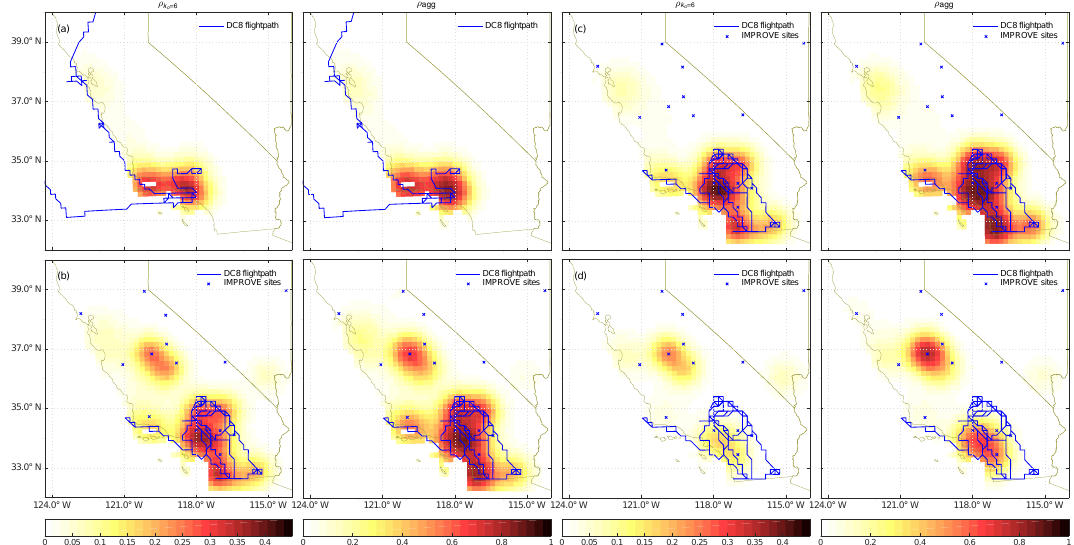
Figure 13. Anthropogenic error reduction in the final outer loop ( ρ k (a) FINN_STD (22), (b) FINN_STD (23/24), (c) ACFT, and (d) SURF inversion scenarios. The ARCTAS-CARB DC8 flightpath and IMPROVE sites at model grid centers are